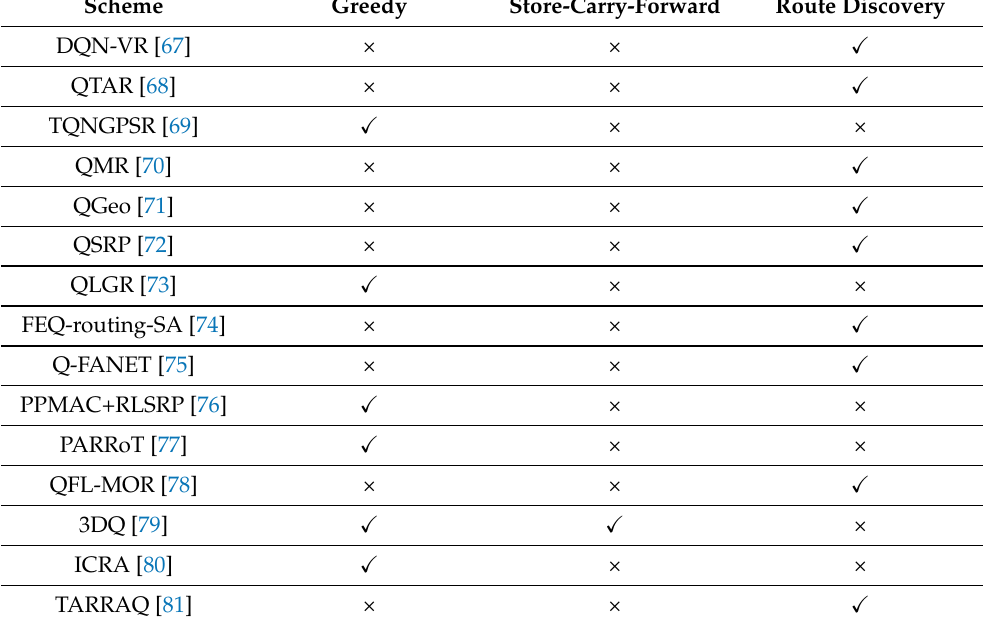
Table 30. Comparison of RL-based routing methods based on data delivery technique. Scheme